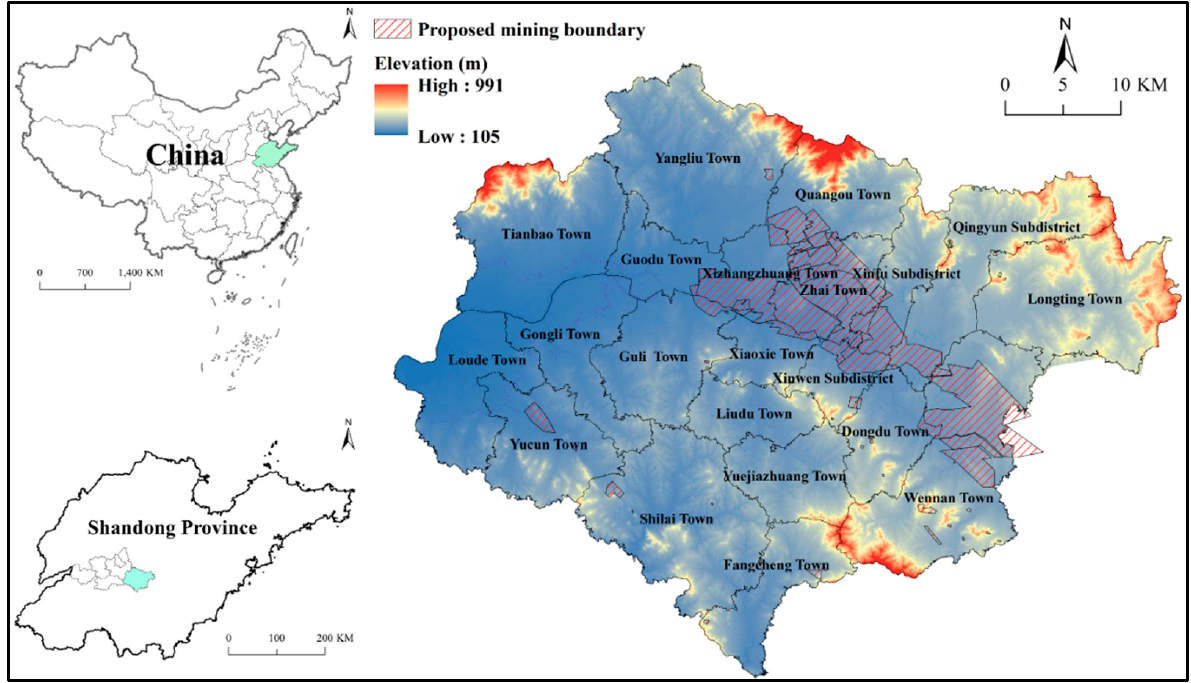
Figure 2. Location and overview of the study area.